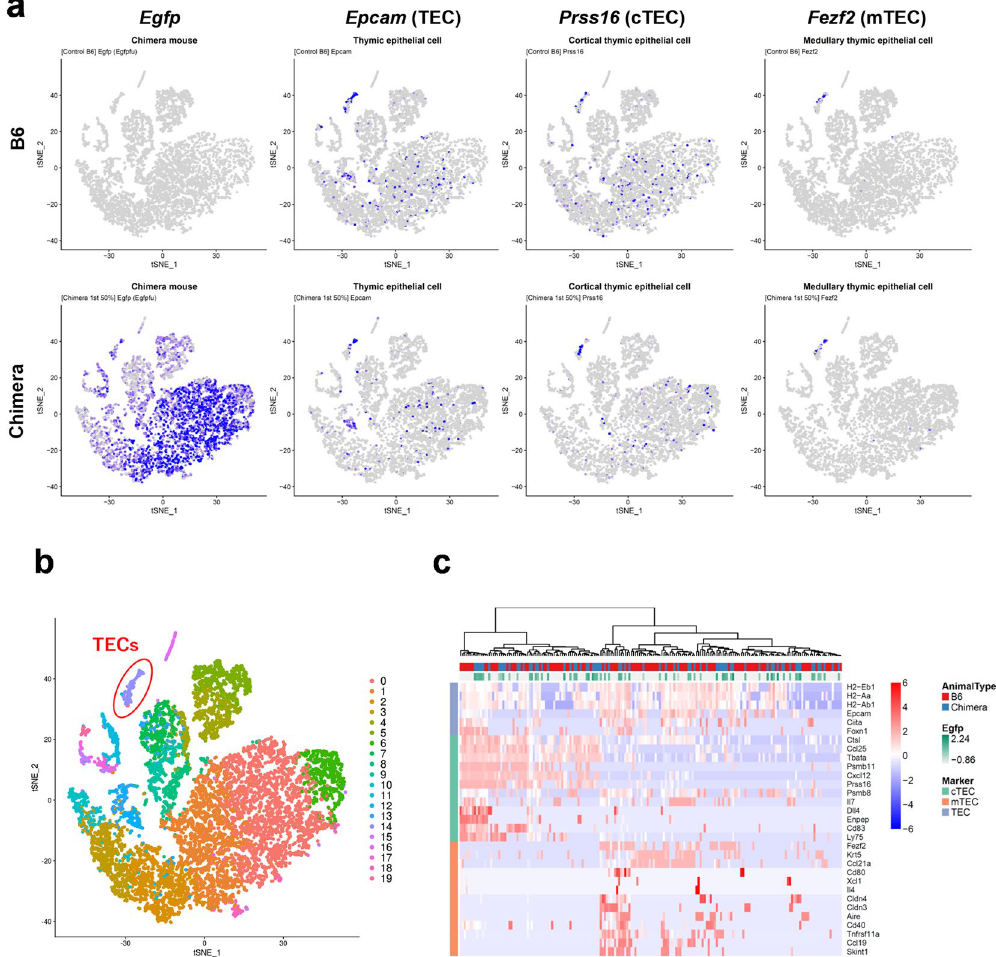
Figure 2. Single-cell transcriptomic profiling of thymus-complemented chimeric mice. ( a ) Projection of whole thymic cells derived from C57BL/6NCrSlc (B6) and B6 ESC CAG-EGFP → KSN/Slc ( Foxn1 nu / nu ) chimeric mice onto two principal dimensions by using t-distributed stochastic neighbor embedding. Egfp , Epcam , Prss16 , and Fezf2 expression was plotted on cells derived from B6 (upper row) and chimeric mice (lower row). Epcam , Prss16 , and Fezf2 are markers of thymic epithelial cells (TECs), cortical TECs (cTEC), and medullary TECs (mTEC), respectively. ( b ) Classification of clustering of cells, resulting in a total of 20 clusters. From the distribution of expression of TEC markers such as Epcam , as indicated in ( a ), a cluster of TECs numbered 14 was detected (red oval). ( c ) Heatmap of single cells extracted from TEC cluster 14 in B6 and thymus-complemented mice. The degree of Egfp expression is shown as green shading in the plot. Cells were categorized by the common TEC, cTEC, and mTEC markers in the left column. Gene expression levels are indicated as scaled normalized unique molecular identified